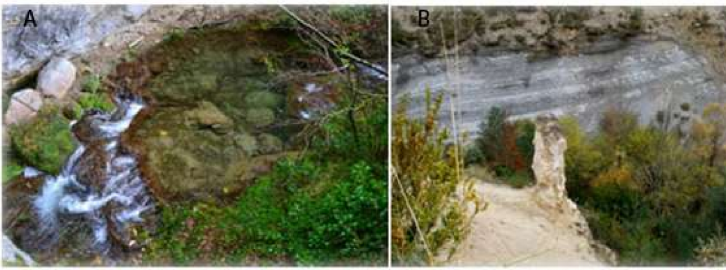
Figure 3. Active and fosil tufa deposits. ( A ) Tufa cascade barrier; ( B ) Calcarenitic